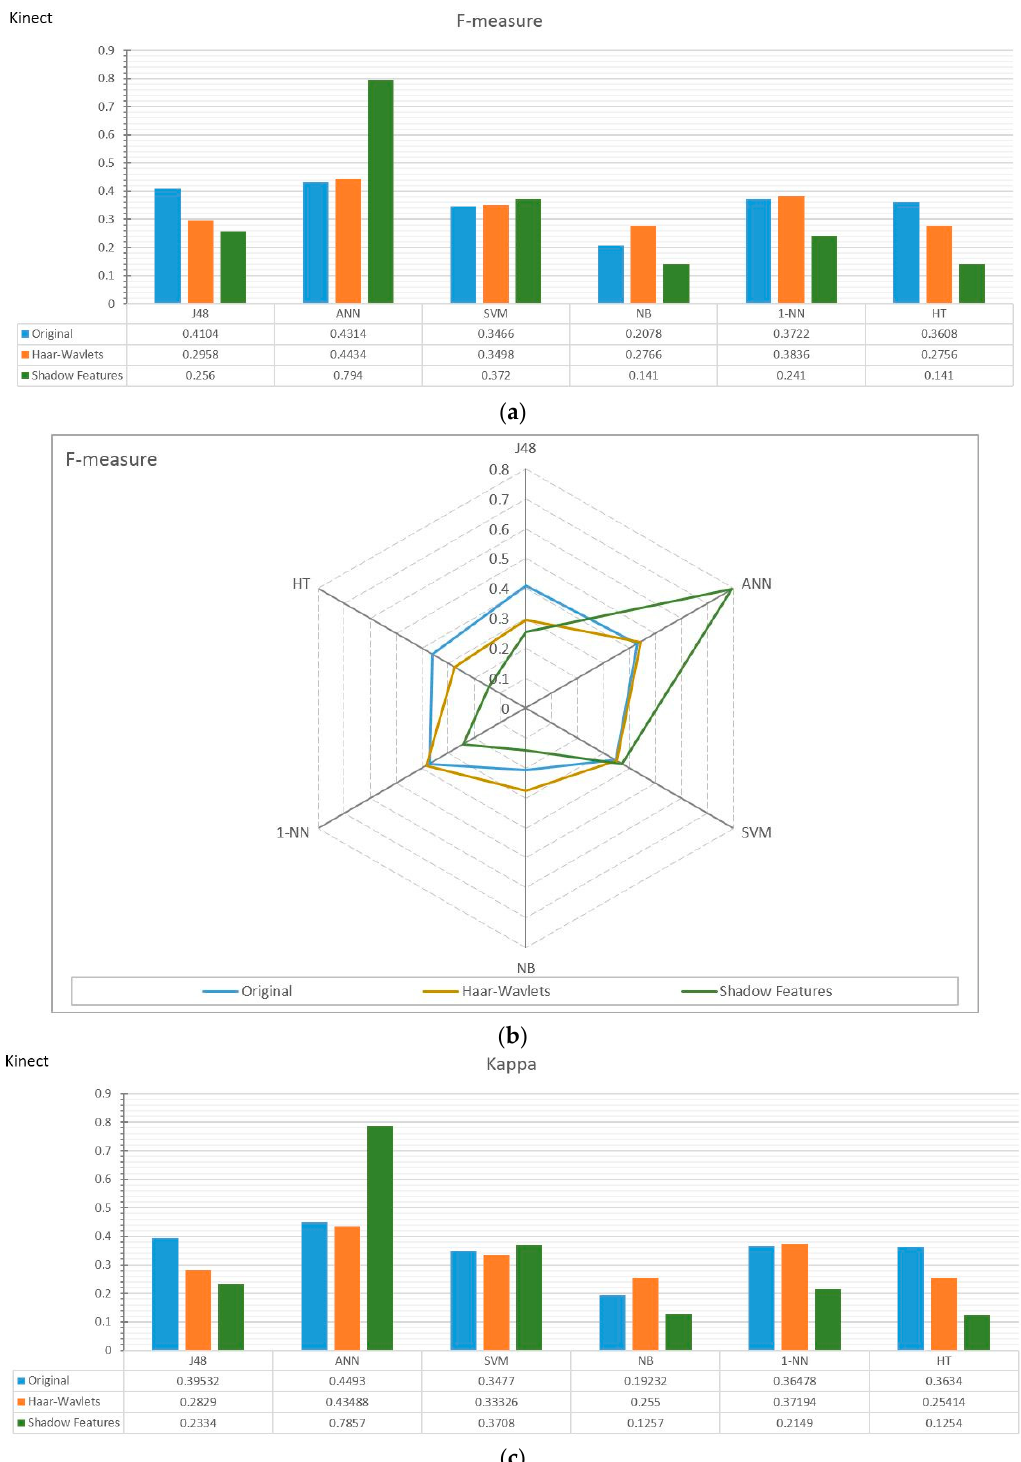
Figure 10. Major performance indicators of classifiers in accelerometer data with different pre-processing strategies based on ( a , b ) F-measure of accelerator; ( c , d ) Kappa values of accelerator, and ( d , e ) Time (sec) in Log scale.